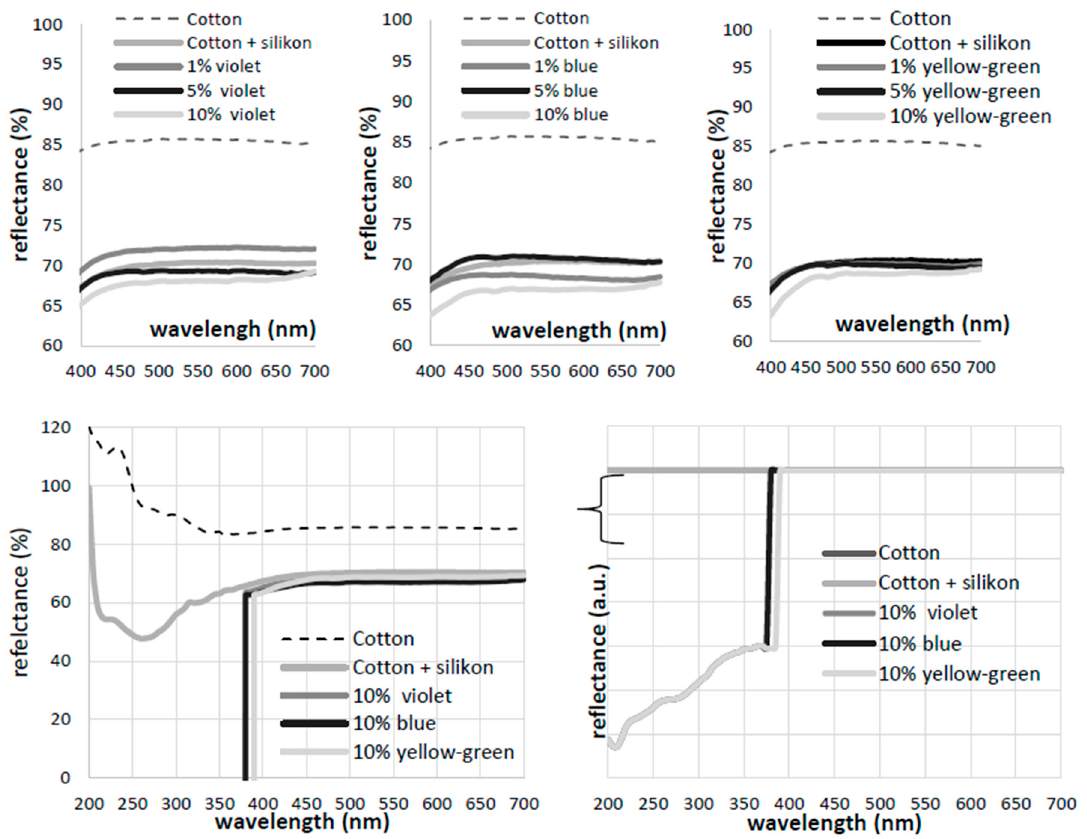
Figure 6. Reflectance spectra of cotton fabrics before and after screen-printing with PDMS containing 0, 1, 5 and 10 wt % of violet, blue and green-yellow photoluminescent